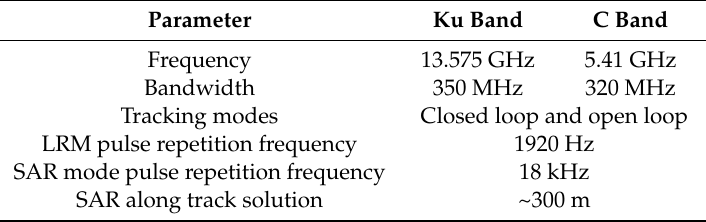
Table 1. Technical characteristics of the Sentinel-3A SRAL